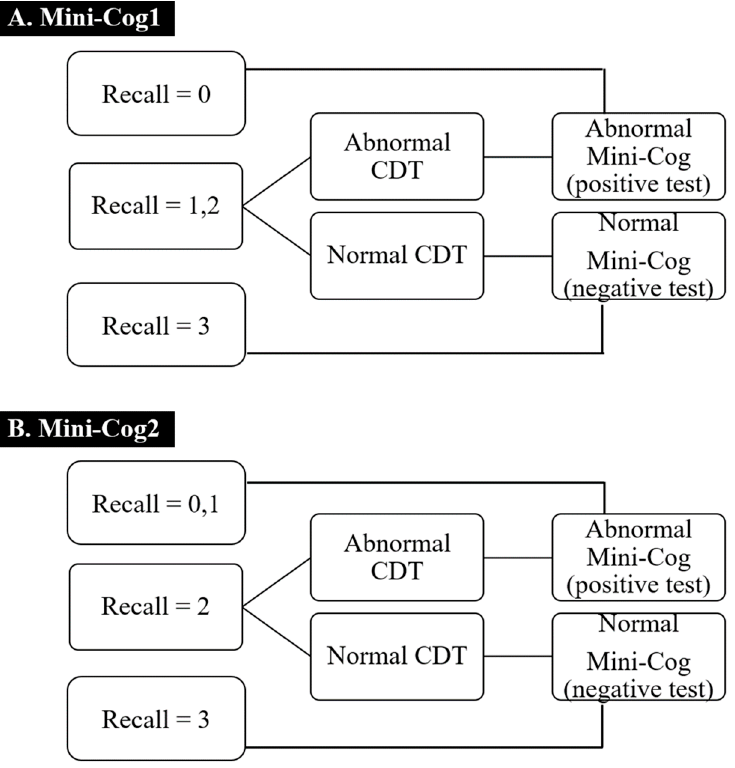
Figure 2. Scoring of the Thai version of the Mini-Cog1 ( A ) and Mini-Cog2 ( B ) [25].